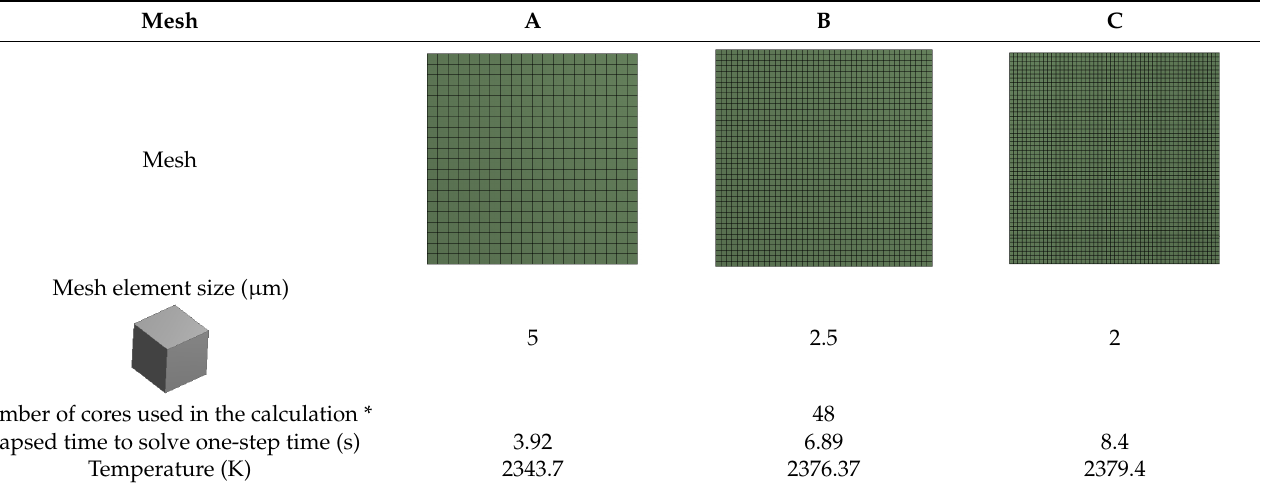
Figure 5. The computational domain (the mesh) used in the analysis (not to scale). Table 2. Discretization levels used in the analysis.